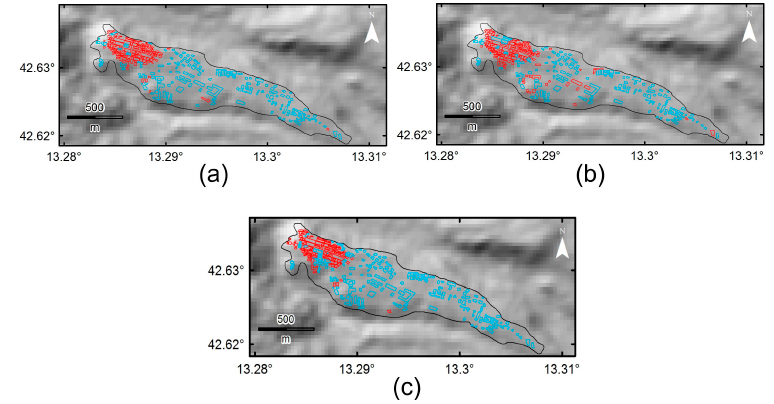
Figure 11. Binary maps for Amatrice deduced from: ( a ) the Sentinel-1 dataset; and ( b ) the ALOS-2 dataset; ( c ) Binary map produced from optical imagery.